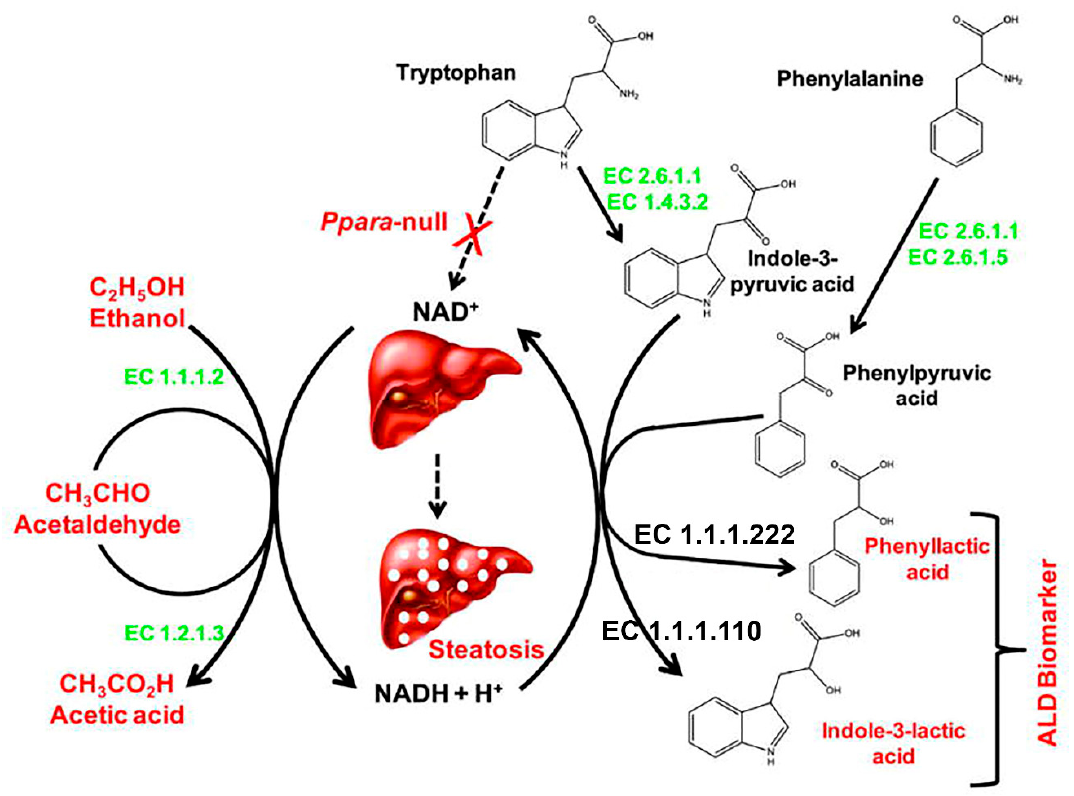
Figure 2. Generation of mechanism-based biomarkers of ALD (adapted from Manna et al., 2011 [59] with permission).